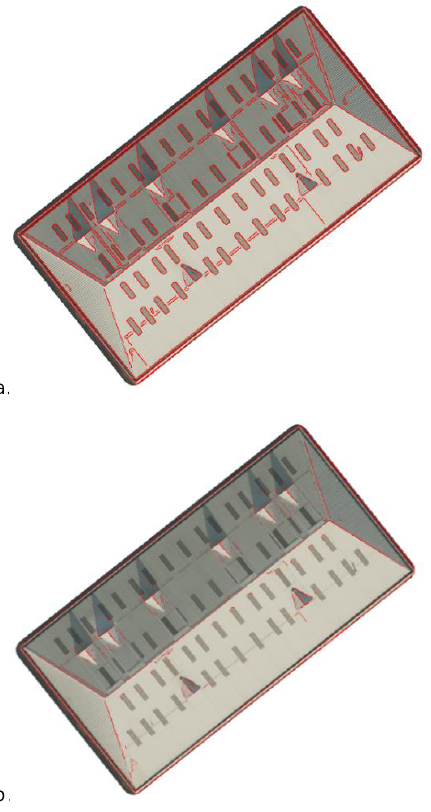
some noise is still present and requires further refinement.